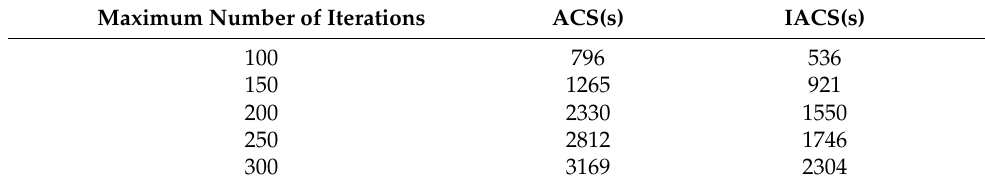
Table 4. Comparison of ACS and IACS.